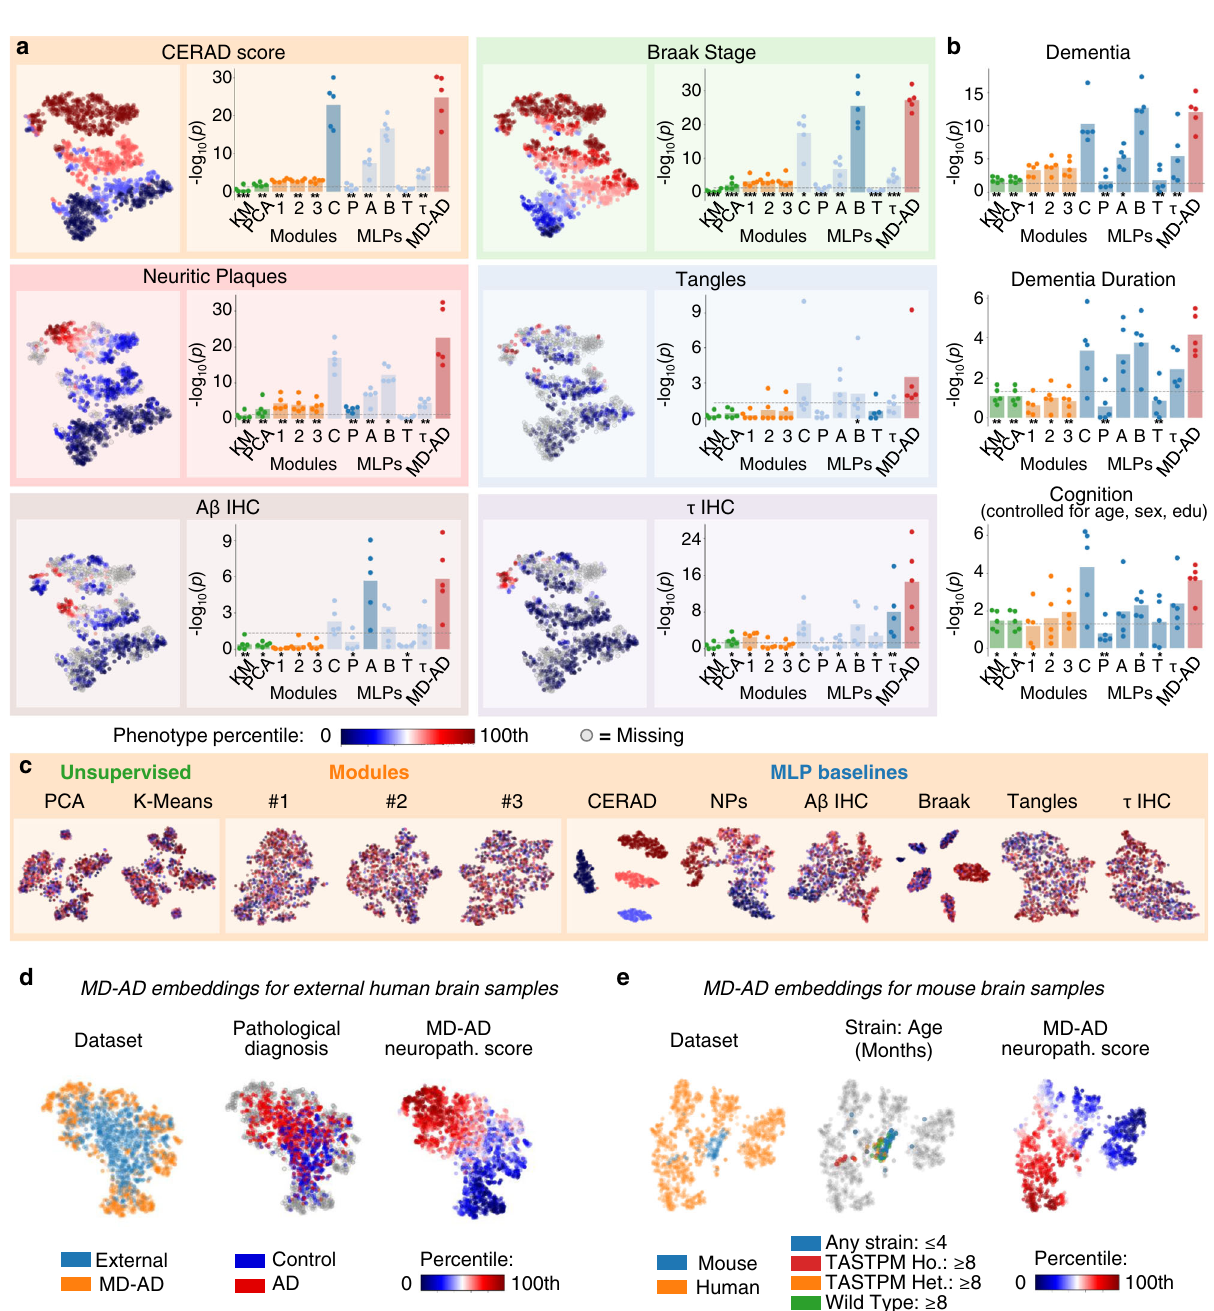
Fig. 3 Comparing MD-AD ’ s supervised embedding to other embedding methods. a For each colored box, Left: two-dimensional t-SNE embedding of MD- AD ’ s last shared layer colored by neuropathological phenotype indicated in the title of the box, Right: − log 10 ( p value) of correlations (averaged across fi ve folds) between “ best ” node from each embedding method and the neuropathological phenotype across 5 test folds. The “ best ” node was identi fi ed as the most signi fi cantly correlated in the training set, but bar height indicates the Pearson correlation − log 10 ( p -value) of the node with the phenotype in their corresponding test sets after FDR correction across nodes (averaged results over fi ve runs; individual points show − log10( p value) from each run). Bar graph columns (left to right): two unsupervised embeddings (green; K-Means and PCA), three module-based embeddings (orange; Modules #1 7 , Modules #2 6 , and Modules #3 9 ), six singly trained MLPs (blue), and MD-AD (red). Results from each method were compared with MD-AD using two-sided paired t tests ( p values indicated below each bar: *<0.05, **<0.01, ***<0.001). b Highest correlation − log p values) (averaged across fi ve folds) found between 10 ( each embedding method and high-level AD variables: dementia (diagnosis prior to death), dementia duration (approximate time between dementia diagnosis and death; available for ACT and ROSMAP), and last available cognition score (controlling for age, sex and education; available for ROSMAP only). All p values listed are shown after FDR correction over the nodes within each method. Bar height indicates the mean over fi ve folds, and points show individual values from each run. c Two-dimensional t-SNE embedding of alternative embedding methods (described in a ), colored by CERAD scores associated with each sample. d Two-dimensional t-SNE embeddings of MD-AD embeddings for training and external datasets. Each point represents a sample colored by dataset (left), AD status for external samples (middle), and MD-AD ’ s predicted neuropathology score (right). e Two-dimensional t-SNE embeddings of MD-AD embeddings for external human and mouse